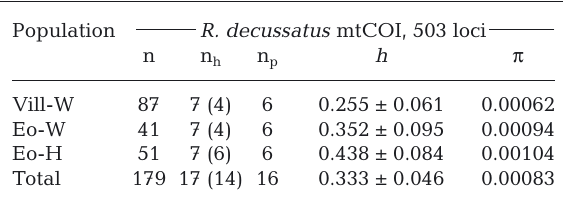
being connected by 1 mutation step (Fig. 4). Hap_6